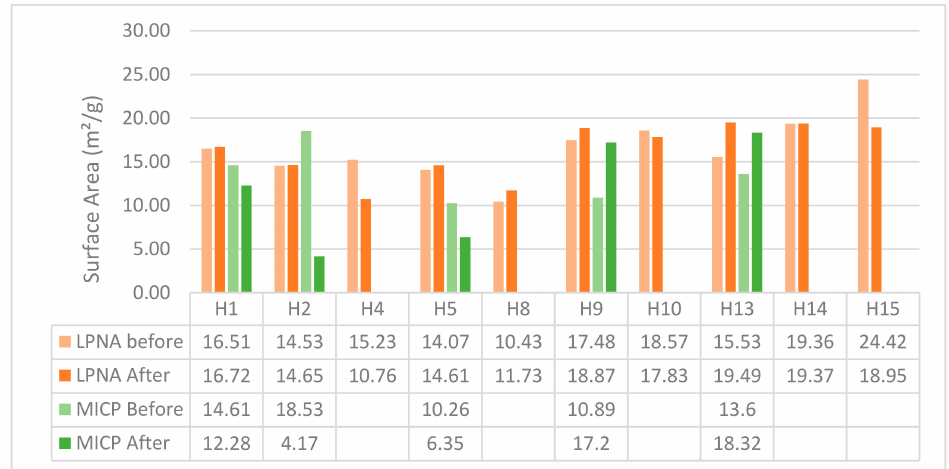
Figure 16. Surface area estimates before and after exposure to scCO 2 from LPNA (orange) and MICP (green).